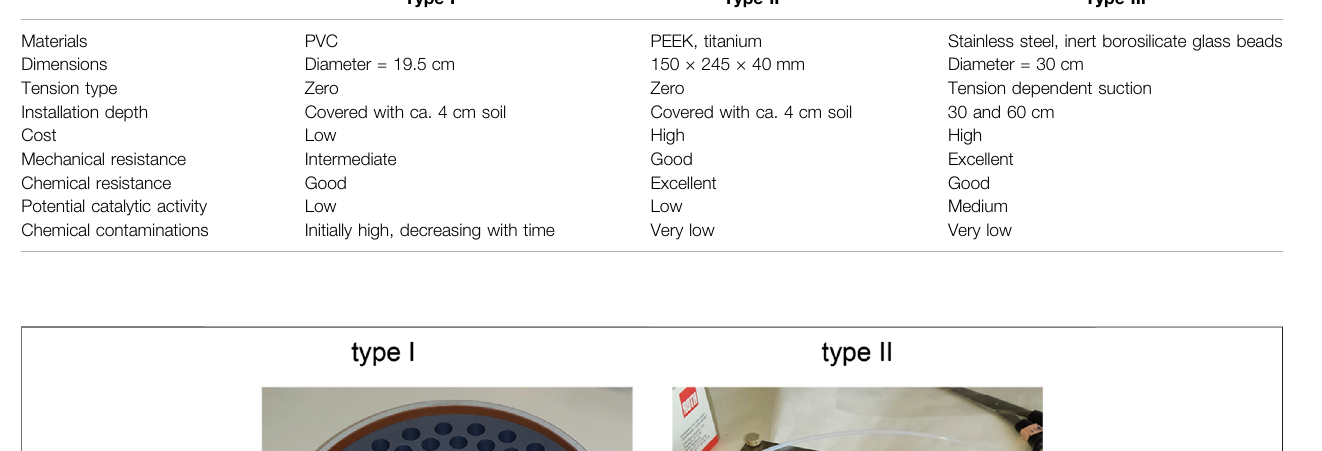
Frontiers in Earth Science |